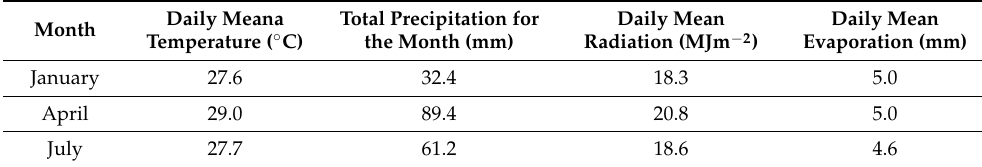
Table 1. Meteorological information of study area.